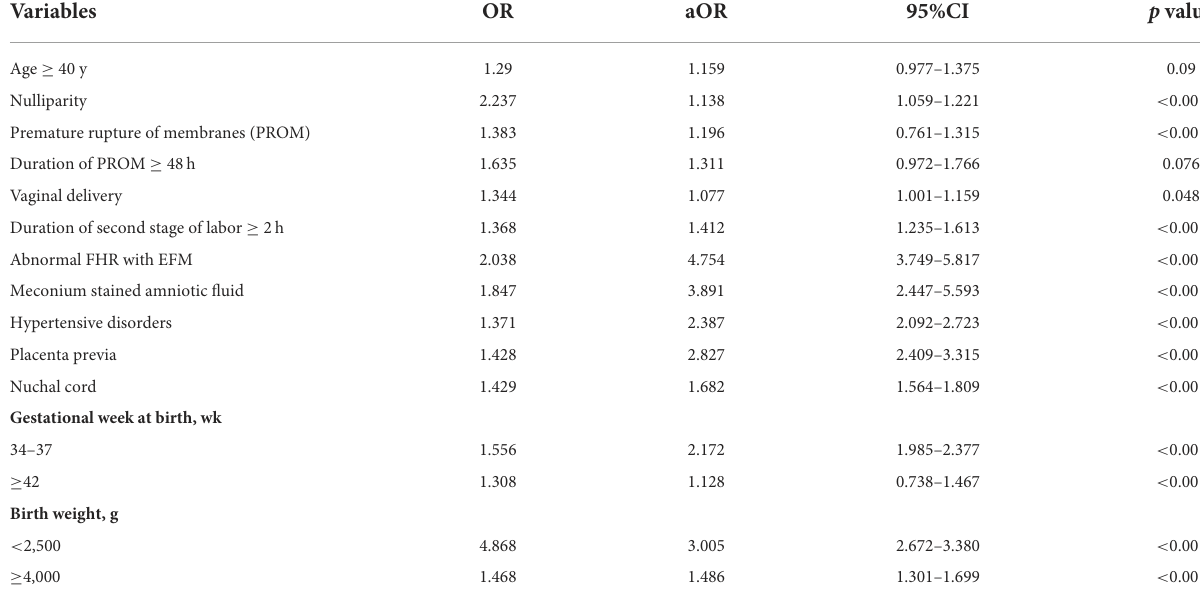
TABLE 4 Univariate and multivariate logistic regression to evaluate the impact of variables on the presence of neonatal asphyxia.